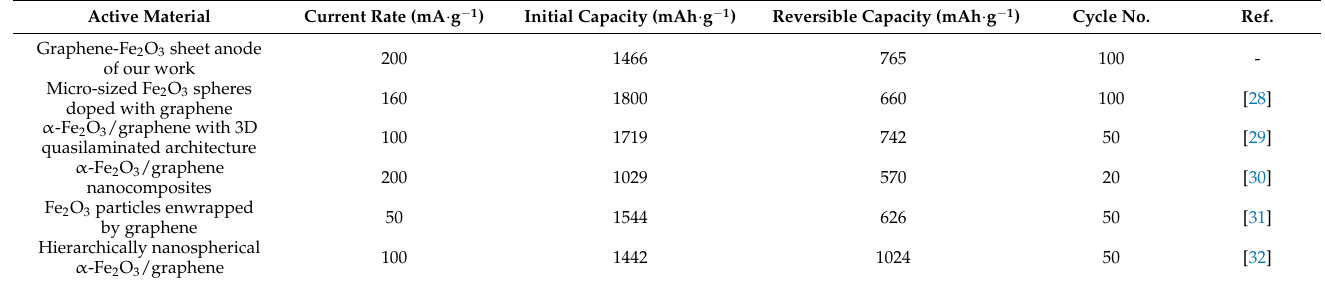
Table 1. Anodes for LIBs based on graphene-Fe 2 O 3 materials and their electrochemical performance.